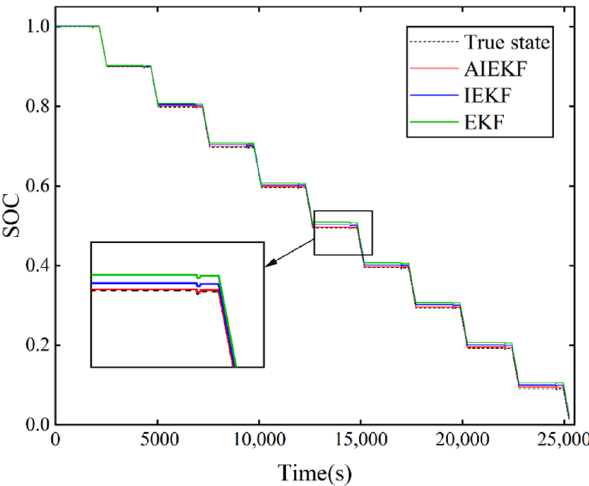
Figure 6. SOC estimation results of AIEKF, IEKF, and EKF under HPPC operating conditions.